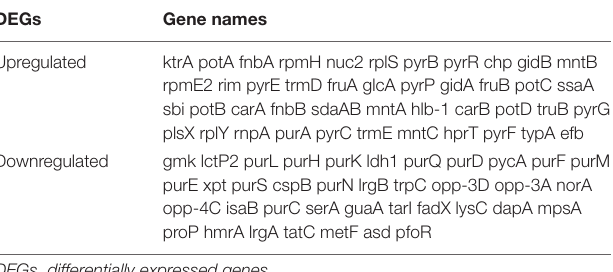
TABLE 2 | Screening DEGs in logarithmic phase by integrated microarray.